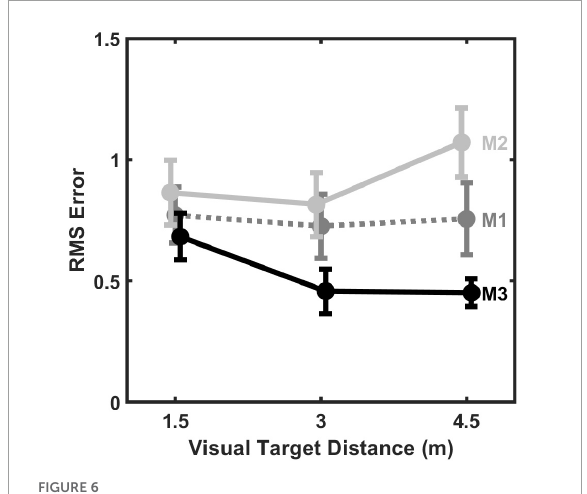
FIGURE6 Mean ( ± 1 standard error) RMS error of 2-parameter ( k aud , r ) model fits to individual subject data ( n = 11) as a function of visual target